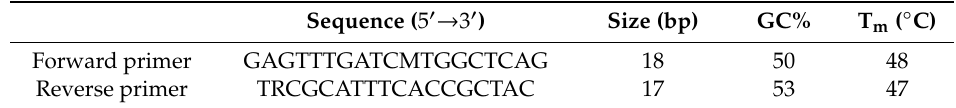
Table 1. Sequence, size, guanine and cytosine (GC) content, and melting temperature (T m ) of a universal pair of primers designed based on the 16S ribosomal RNA gene of five di ff erent bacteria. Sequence ( 5 (cid:48) → 3 (cid:48) )